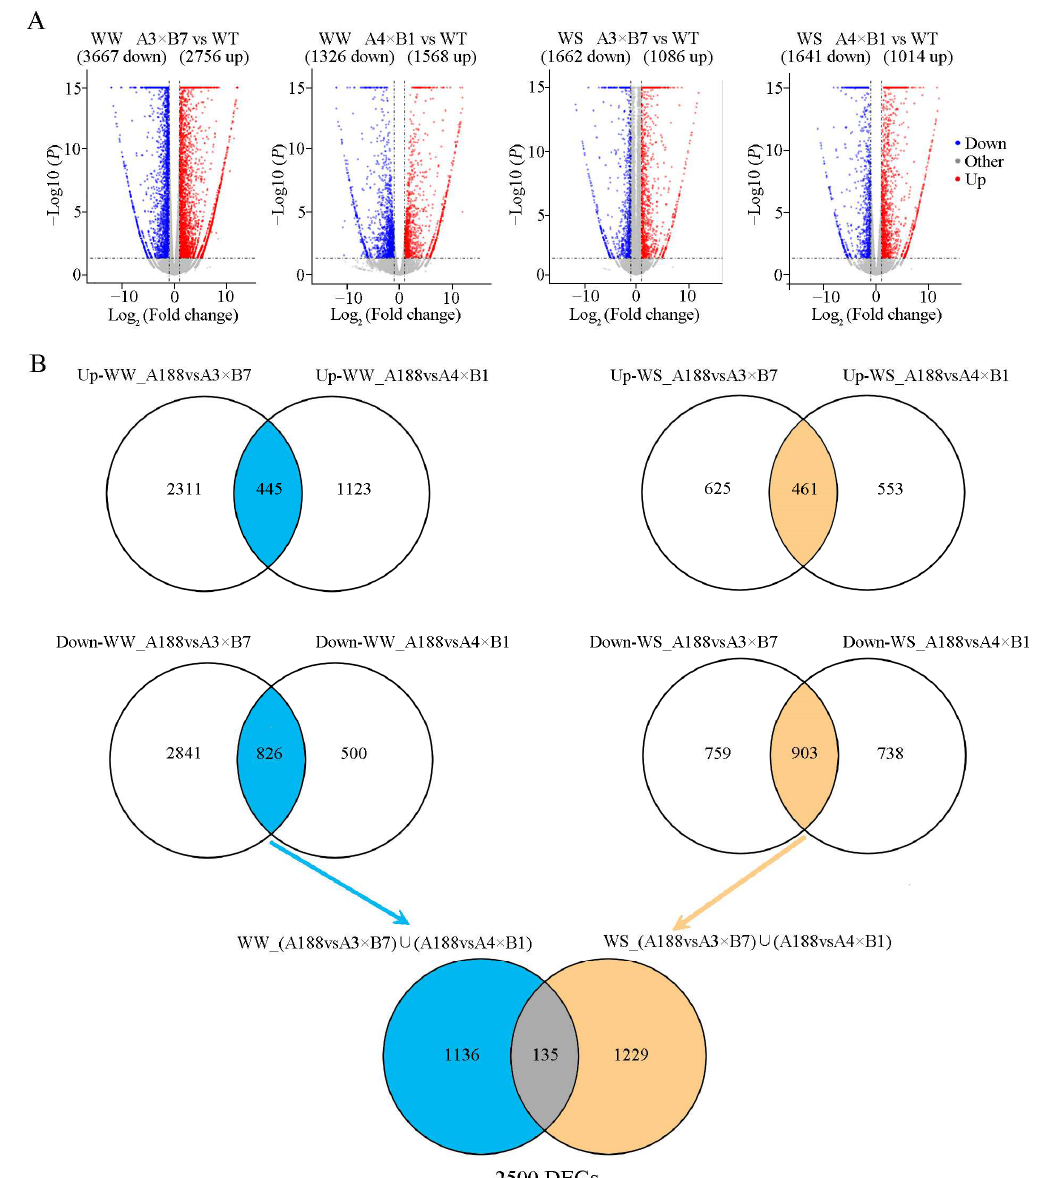
Figure 5. Transcriptomic analysis of dual transgene and WT maize under full irrigation and drought conditions. ( A ) Volcano plots of DEGs ( p -value < 0.05 and |log2|-fold change > 1). ( B ) Venn diagrams of DEGs for the dual transgene and WT maize under full irrigation and drought conditions.